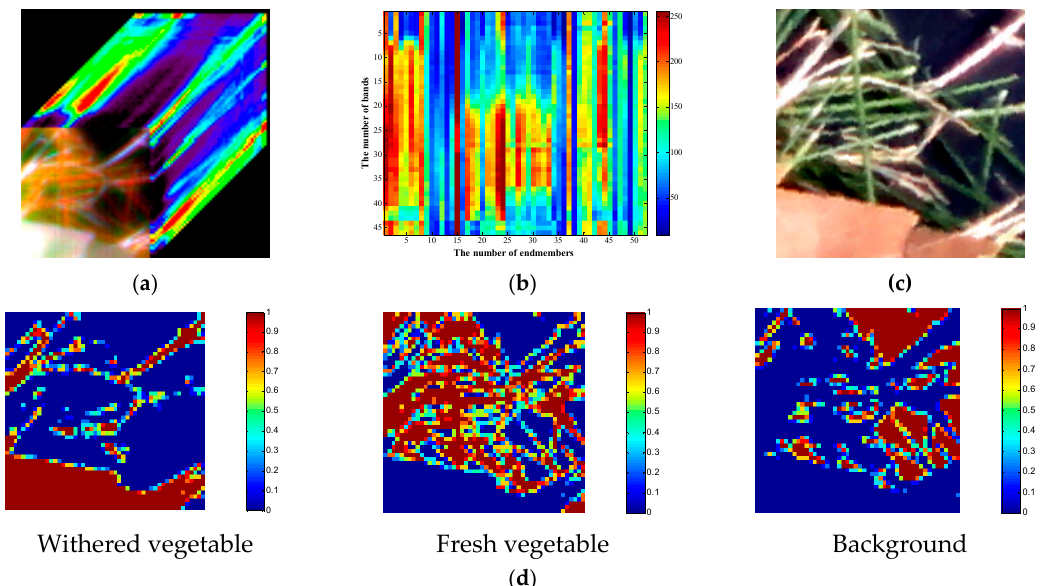
Figure 9. R-1. ( a ) R-1-hyperspectral dataset. ( b ) Spectral library. ( c ) HR image. ( d ) Reference abundances.